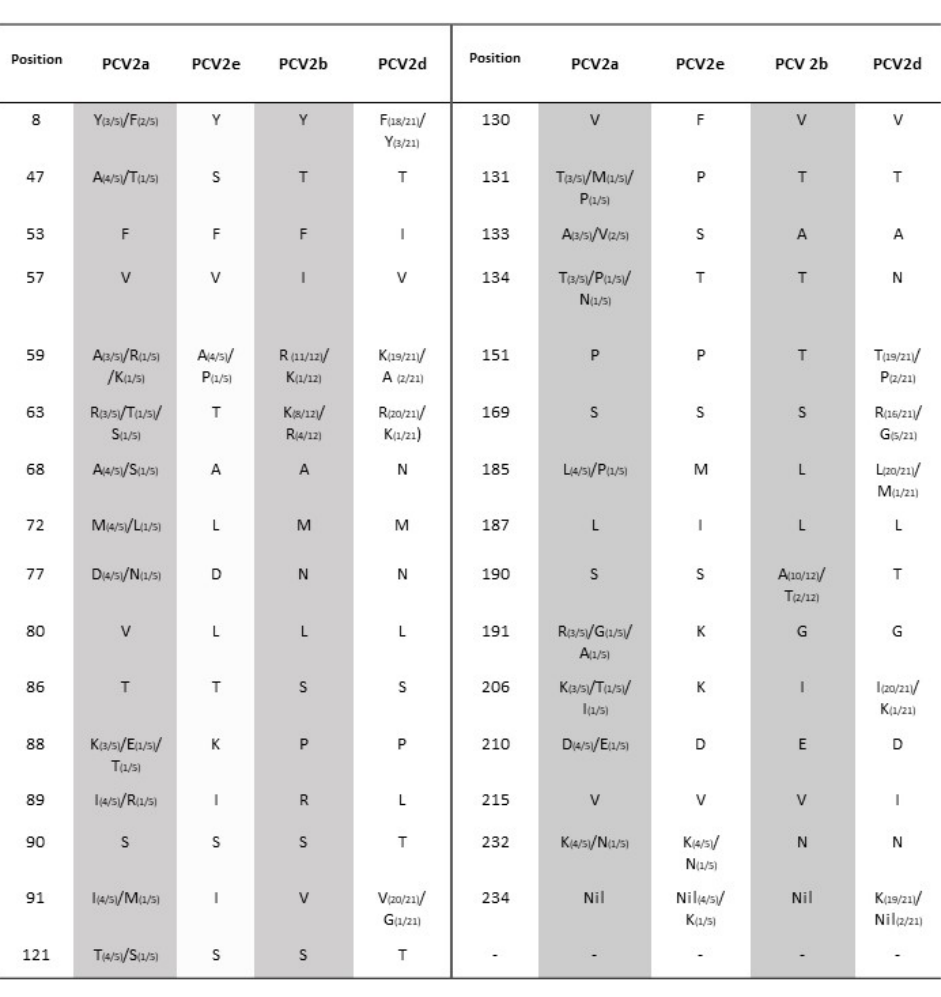
Figure 2. Critical amino acid substitutions in ORF2 of various PCV2 genotypes, i.e., PCV2a, PCV2b, PCV2e, and PCV2d.